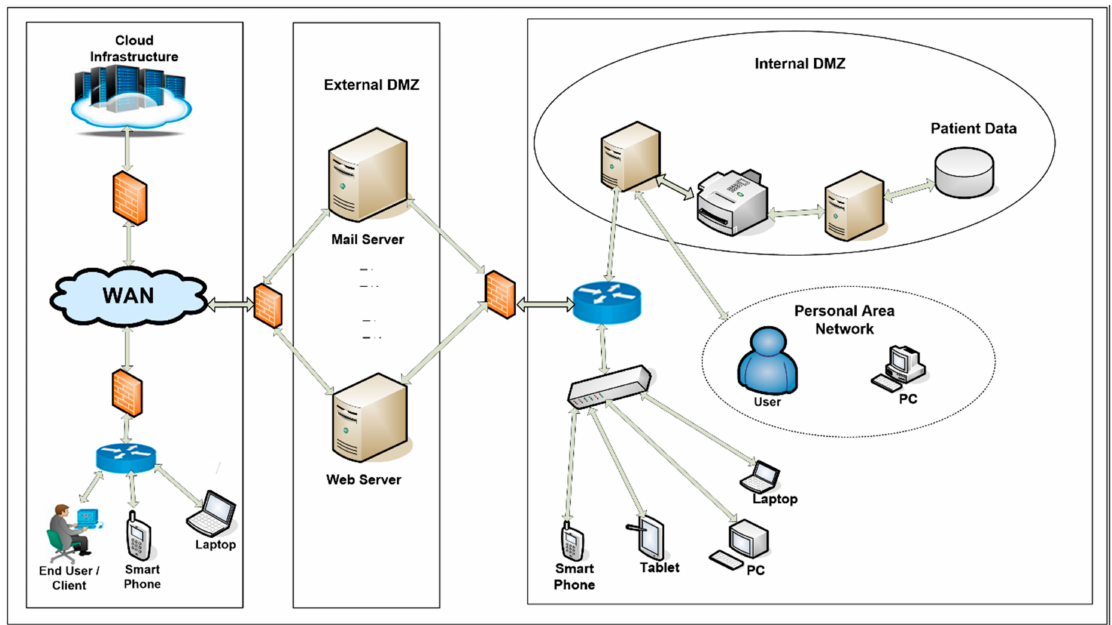
Figure 1. Smart Healthcare